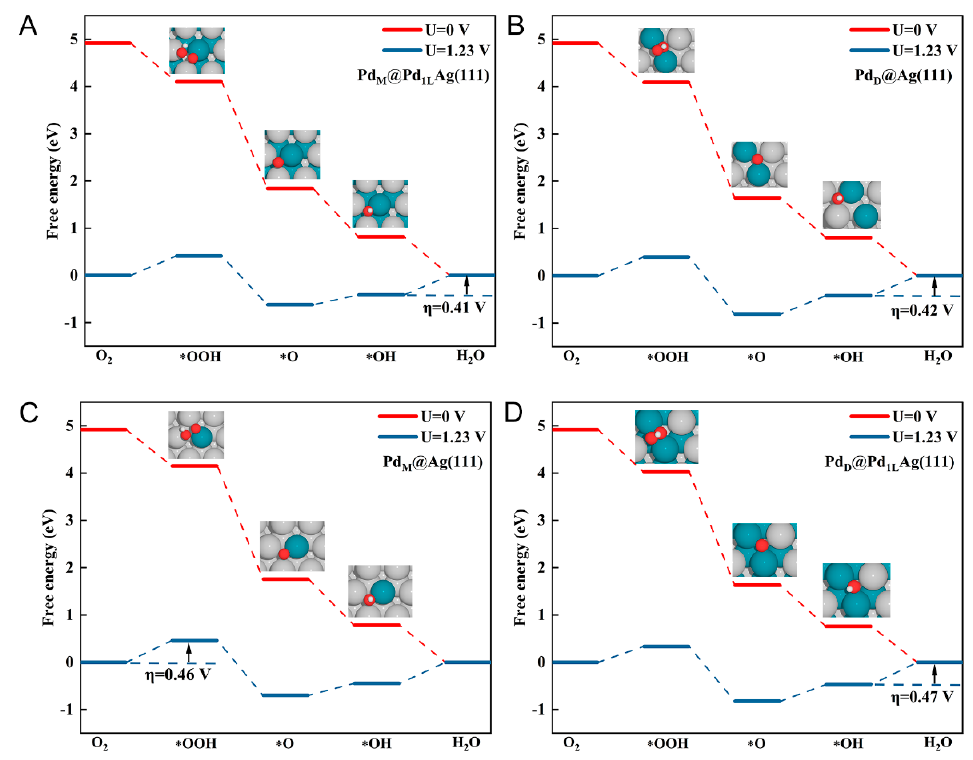
Figure 2. Gibbs free energy diagrams for the ORR pathway at the equilibrium potential (U = 1.23 V), and zero potential on the four lowest overpotential surfaces. ( A ) Pd M @Pd 1L Ag(111), ( B ) Pd D @Ag(111), ( C ) Pd M @Ag(111), and ( D ) Pd D @Pd 1L Ag(111). The silver, cyan, red, and white balls represent Ag, Pd, O, and H atoms, respectively.